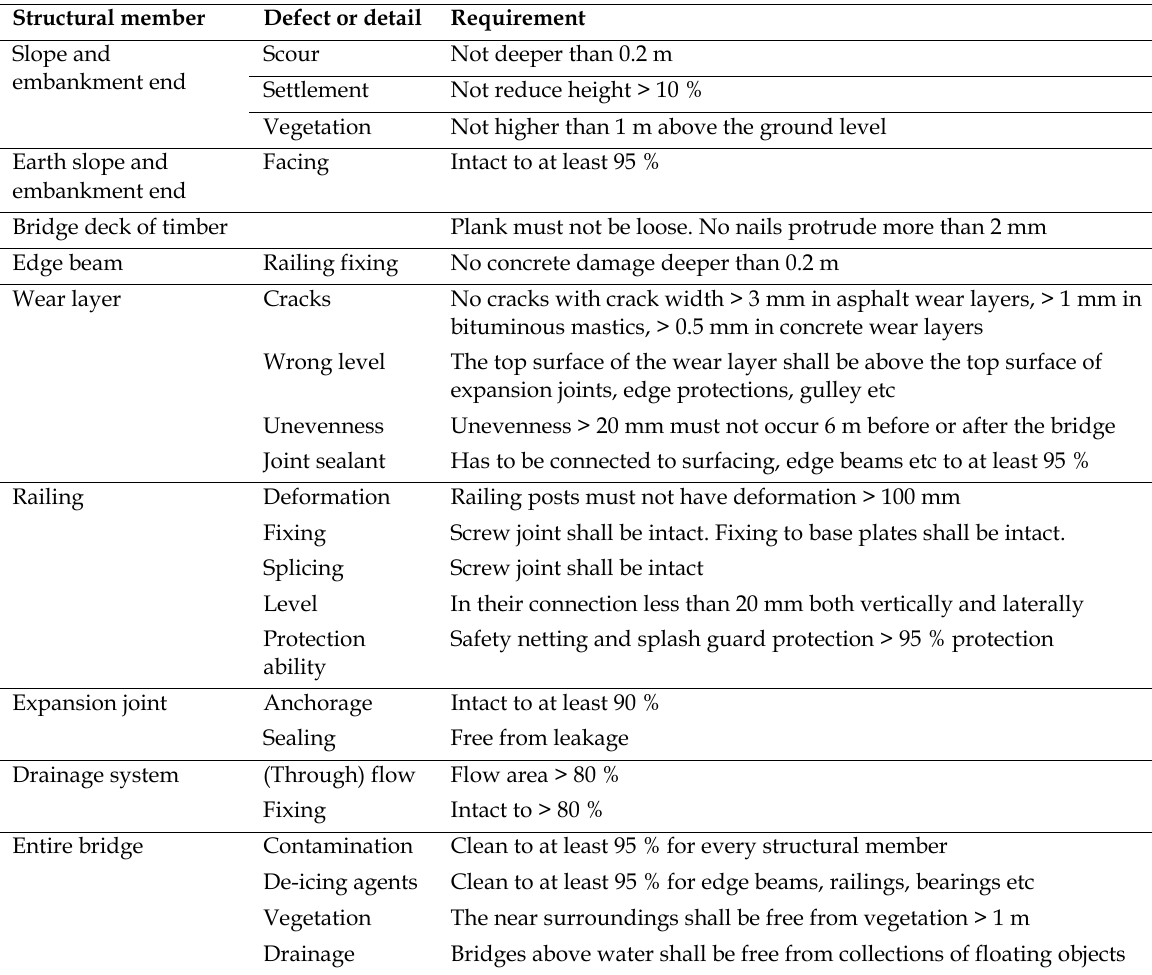
Table 1. Summary of technical requirements for preventive maintenance in Sweden. After Silfwerbrand